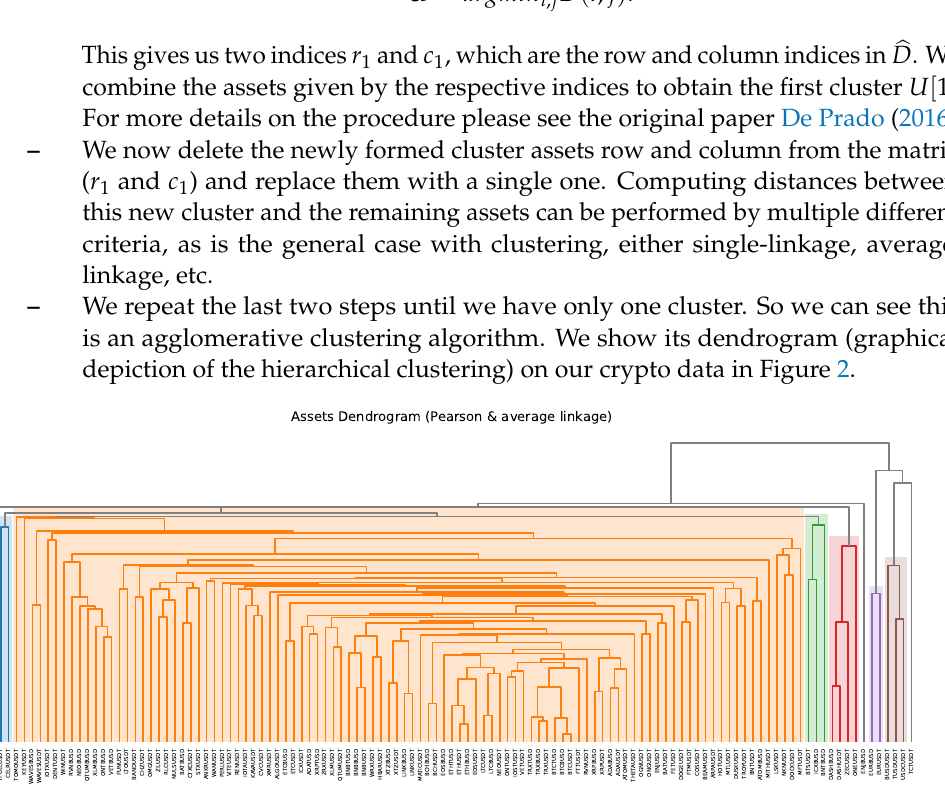
Figure 2. Dendrogram of the hierarchical clustering of the crypto assets.